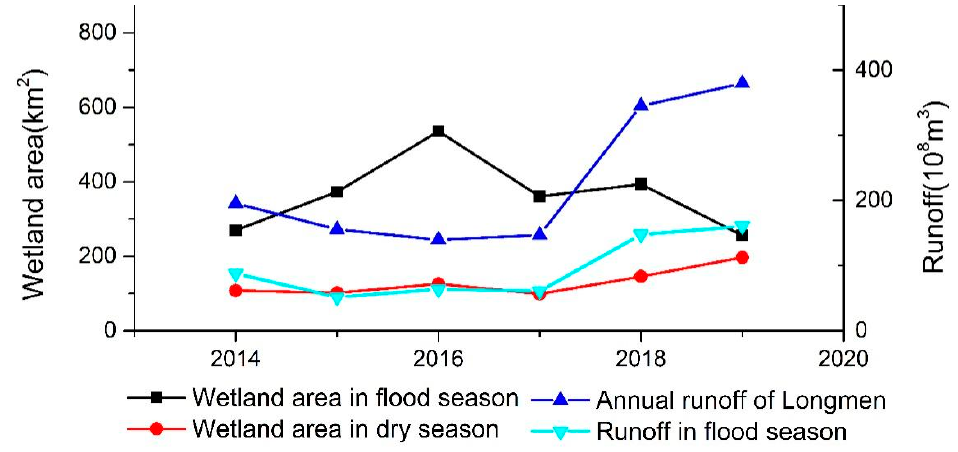
ff from 2014 to